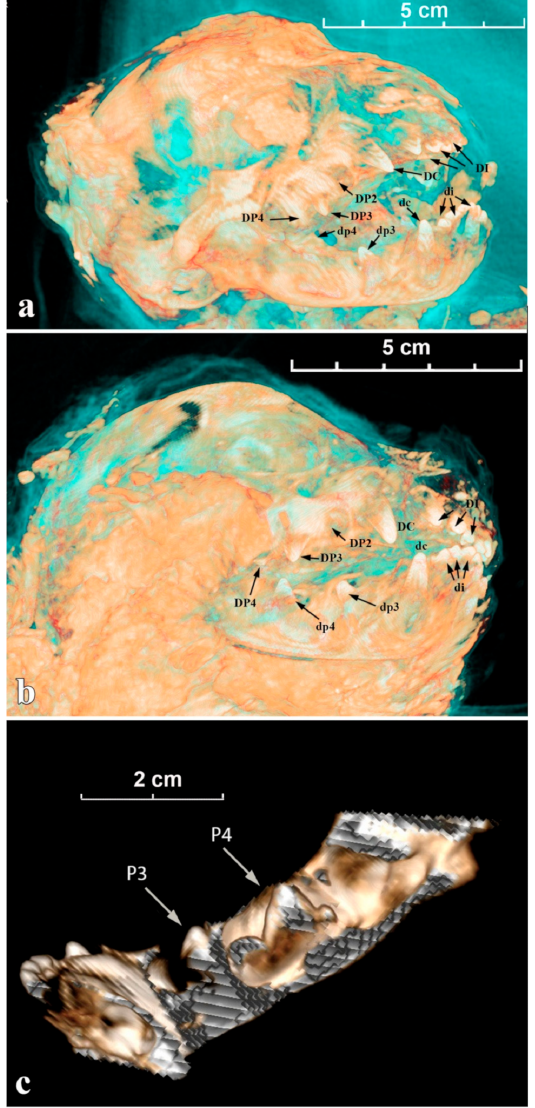
Figure 5. The tomographic images of cave lion cubs’ skulls and mandibles with marked deciduous teeth: ( a ) Sparta’s skull; ( b ) Boris’s skull; ( c ) Sparta’s